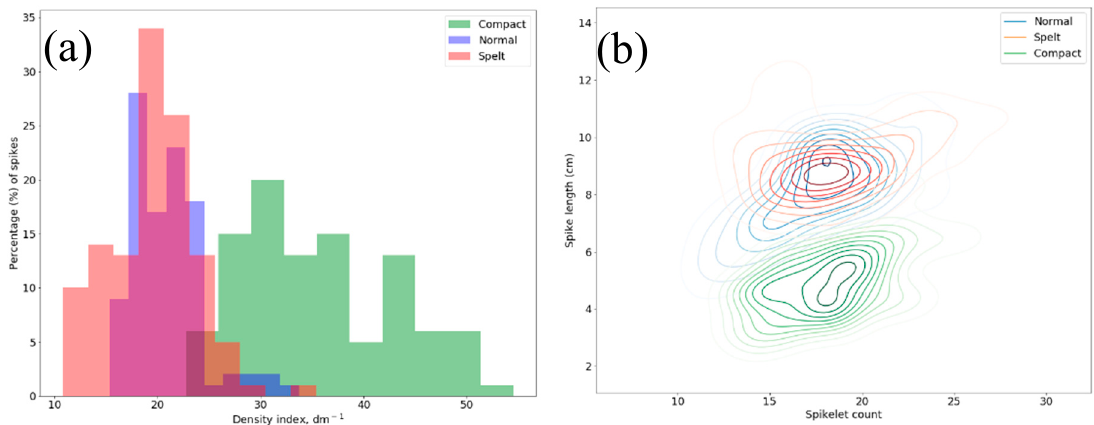
Figure 8. ( a ) Histogram of spike distribution according to density index and ( b ) diagram of spike distribution according to the number of spikelets per spike and spike length. Color is associated with spike shape: Green denotes a compact spike; blue, normal; and red, a spelt one.